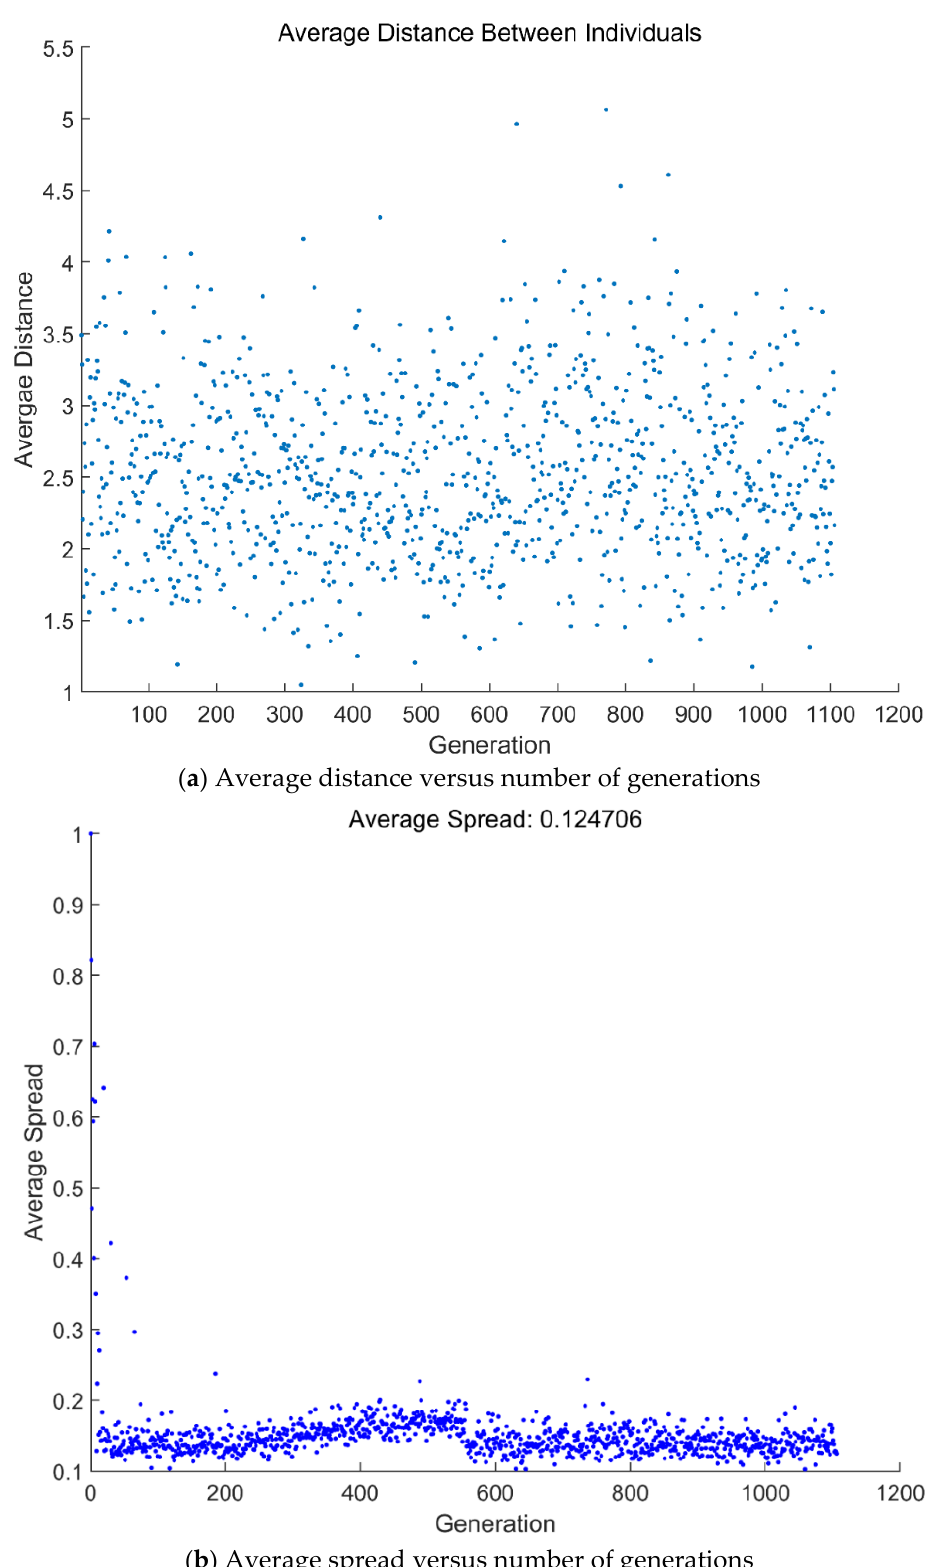
Figure 8. Average distance and average spread versus number of generations ( P η− ).